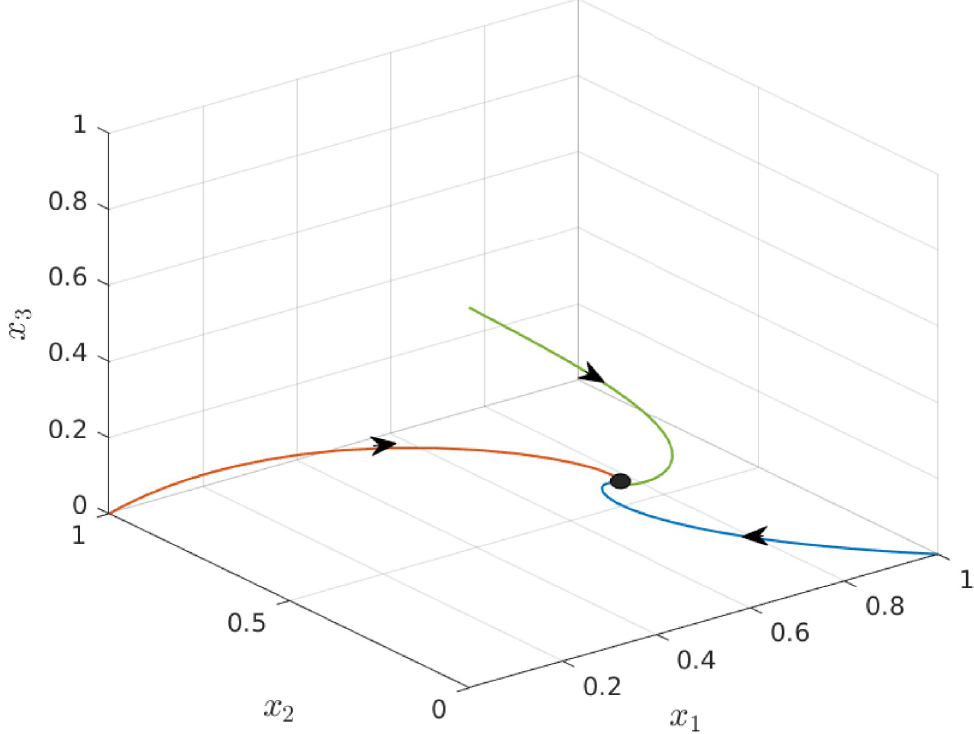
Fig 3. Trajectories of EFEIOD for three initial conditions given in Example 3 as a function of time. The equilibrium point is marked by a ellipse.